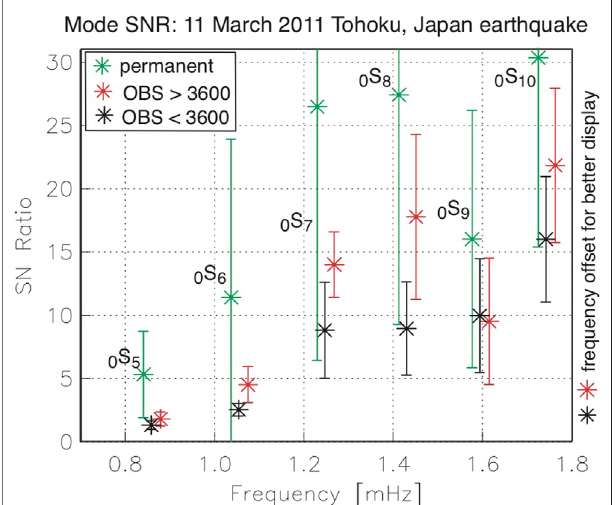
FIGURE 15 | Average of signal-to-noise ratios for the 16 ALBACORE stationsthat hadusefulseismic data(15broadband,1wideband). The results are slightly offset in frequency betweeninstrument types for better display. Six grade-E or F stations were discarded and not included (5 broadband, 1 wideband). Black: 10 OBSs in deeper water ( > 3,600 m). Red: 6 OBSs in shallower water ( < 3,600 m). Green: Average over 10 records at nine permanent land stations (shown in Figure 13